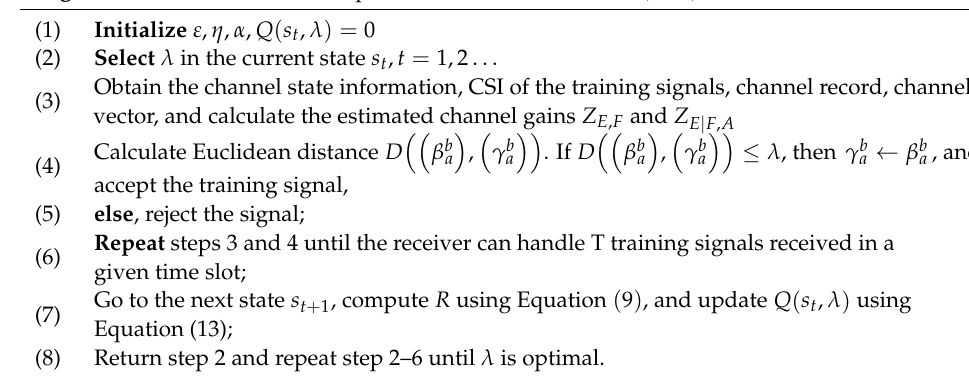
Algorithm 1 SARSA-enabled impersonation attack detection (IAD) method